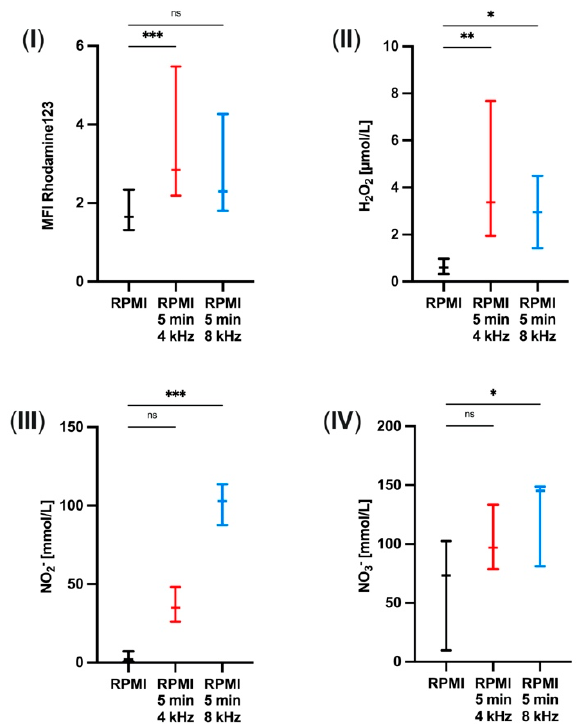
Figure 3. Increase in ROS and RNS concentrations in the plasma-treated solution. ( I ) Median fluorescence intensity (MFI) of Rhodamine123, ( II ) the concentration [ µ mol/L] of H 2 O 2 , ( III ) the concentration [mmol/L] of NO 2 − , and ( IV ) the concentration [mmol/L] of NO 3 − in RPMI 1640 dosed with 10% fetal bovine serum after 5 min of 4 kHz and 8 kHz CAP treatment ( n = 4, each with 3 technical replicates) detected by fluorescence measurements. Statistical analysis: Kruskal–Wallis test. * p < 0.05, ** p < 0.01, *** p < 0.001, ns: not significant.